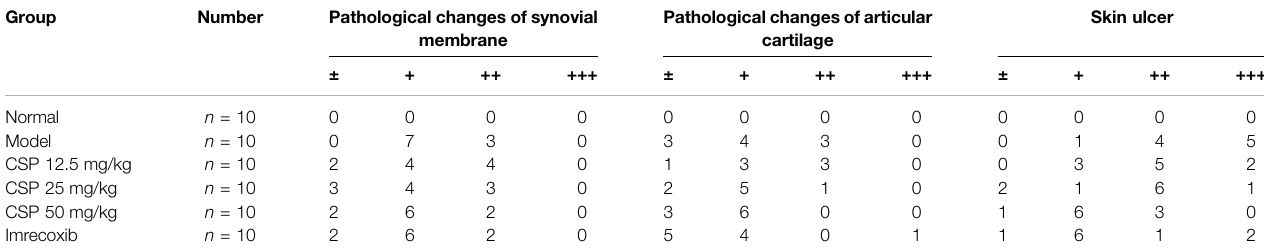
TABLE 1 | Statistical analysis of abnormal changes of hind paw in different groups. Group Number Pathological changes of synovial